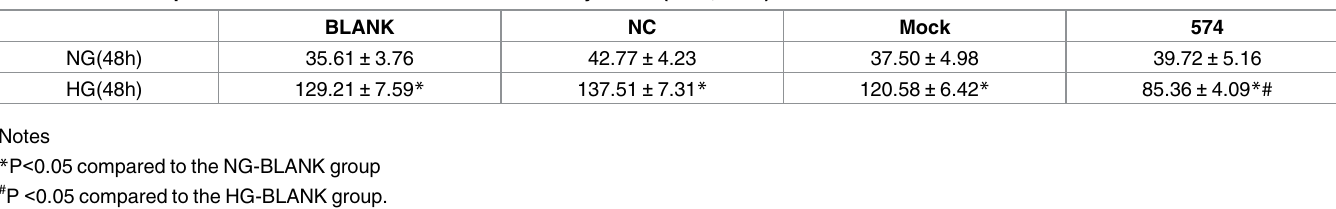
Table 2. Protein expression of FN in HK-2 cells as determined by ELISA ( x (cid:6) s , n =